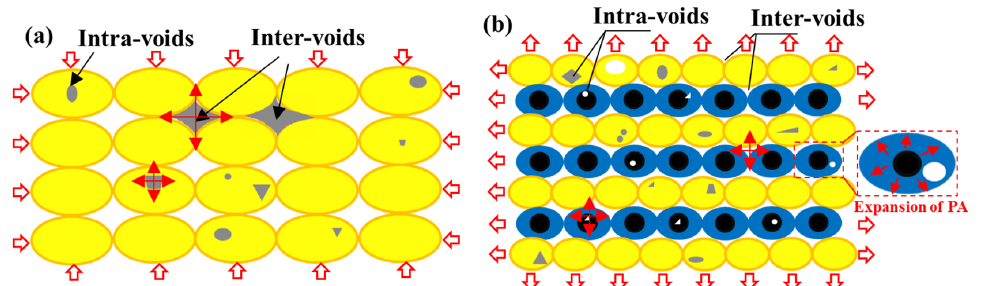
Figure 11. Schematic diagram to describe the effect of heat treatment process on dimensional change of FDM 3D-printed fiber-reinforced PEEK composites: ( a ) FDM 3D-printed of FDM 3D-printed fiber-reinforced PEEK composites: ( a ) FDM 3D-printed short-fiber-reinforced short-fiber-reinforced PEEK composites; ( b ) FDM 3D-printed continuous-fiber-reinforced PEEK PEEK composites; ( b ) FDM 3D-printed continuous-fiber-reinforced PEEK composites.